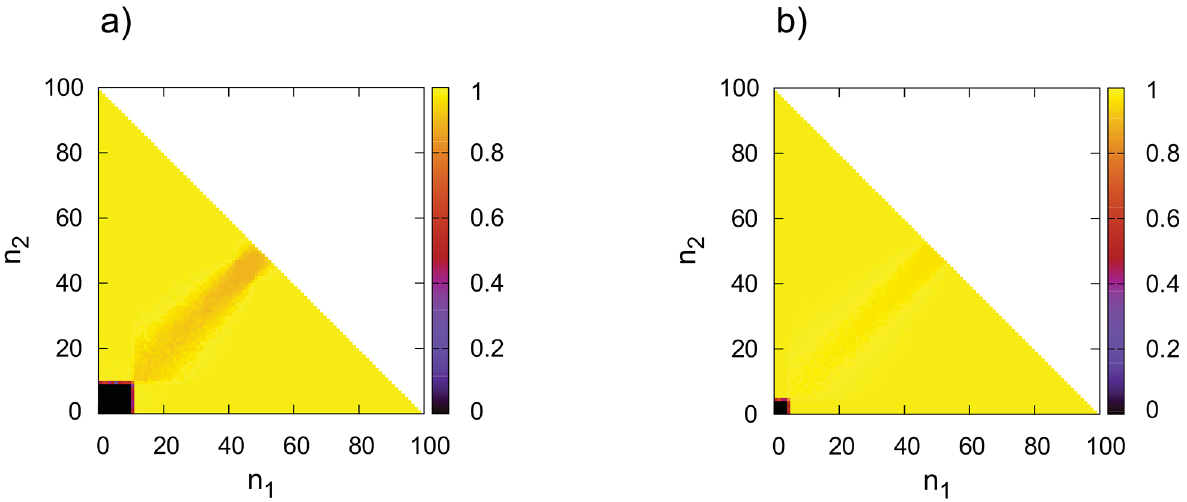
Figure 3. Dynamics of the linear model in function of initial sizes of P blocks ( n 1 and n 2 respectively). Colors reflect to the frequency of P cells in the equilibrium (darker means less fraction of P cells). a ) DpB update rule, the cost of producing diffusive material is higher d ~ 1 : 2 , b ) DpB update rule, the cost of producing diffusive material is lower, d ~ 0 : 5 . Other parameters are N ~ 100 , a ~ 1 , l ~ 10 . The depicted values are averages of 50 independent simulations. By using pDB update rules gives practically the same results, so they are not showed.